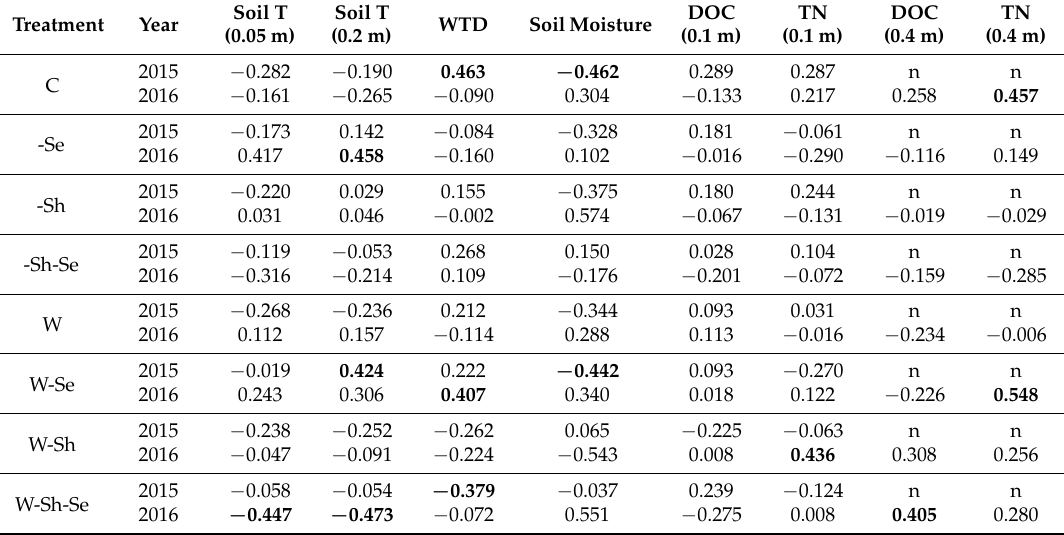
Table 3. Coefficient matrix table between N 2 O fluxes and environmental parameters during the growing seasons of 2015 and